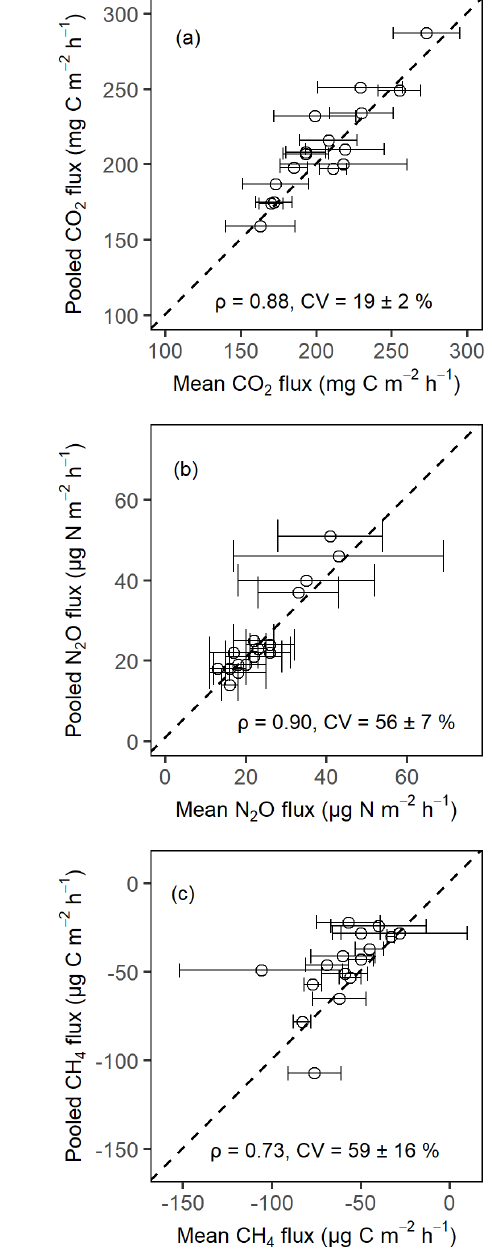
Figure A1. Comparison of the soil CO 2 fluxes (a) , soil N 2 O fluxes (b) , and soil CH 4 fluxes (c) from pooled sampling and the mean of four chamber measurements for the month of February 2020 in the Budongo Central Forest Reserve. ρ is the Spearman correlation coefficient, and CV is the coefficient of variation. Error bars are derived from standard error of the